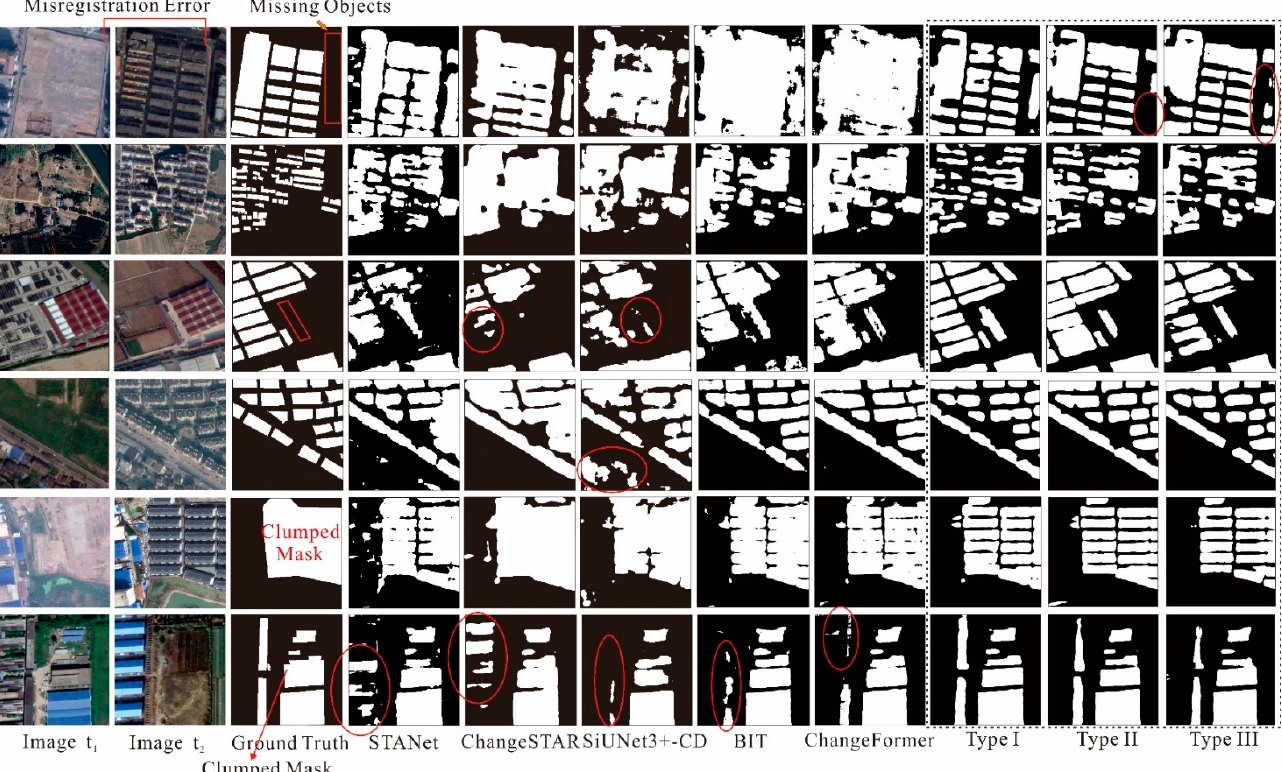
Figure 6. Visualized results of STDecoder-CD series models and the compared methods on the PIESAT-CD dataset. Red rectangles represent missing annotations in the labels. Red ellipses highlight typical false alarms. Note: due to limited space, we could not show the prediction results of all of the algorithms listed in Table 1.